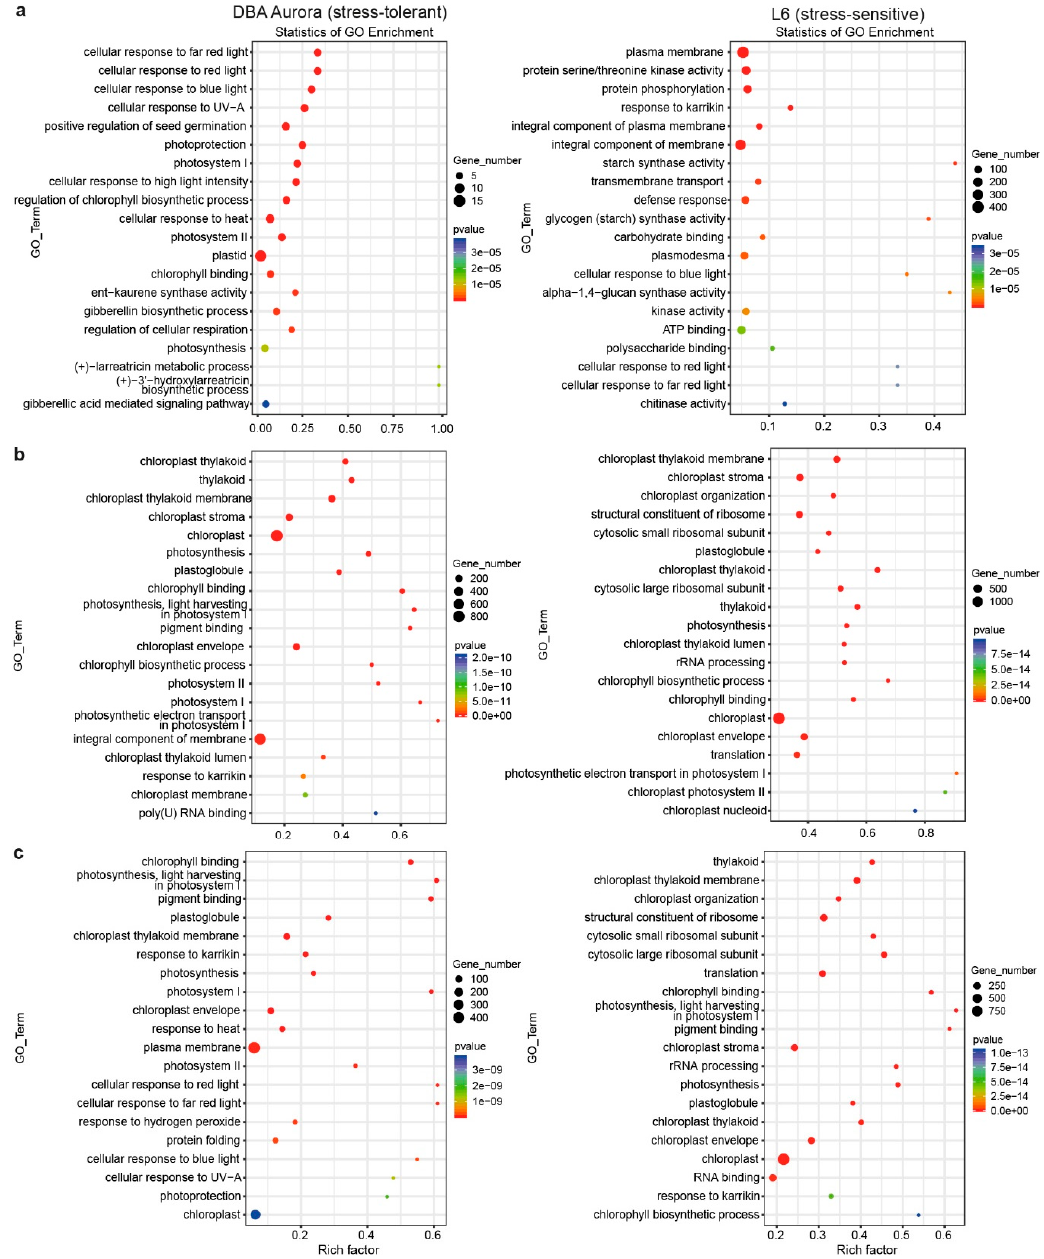
Figure 2. Gene ontology (GO) enrichment analysis of stress-responsive DEGs (differentially expressed genes, p < 0.05) under stress. ( a ) In response to water-deficit stress. ( b ) In response to heat stress. ( c ) In response to water-deficit plus heat stress. GO terms on the Y-axis are ranked by p -value in the enrichment analysis. Rich factor stands for the ratio of DEG number to the total number of genes that have been annotated under this GO term (i.e., the degree of enrichment).